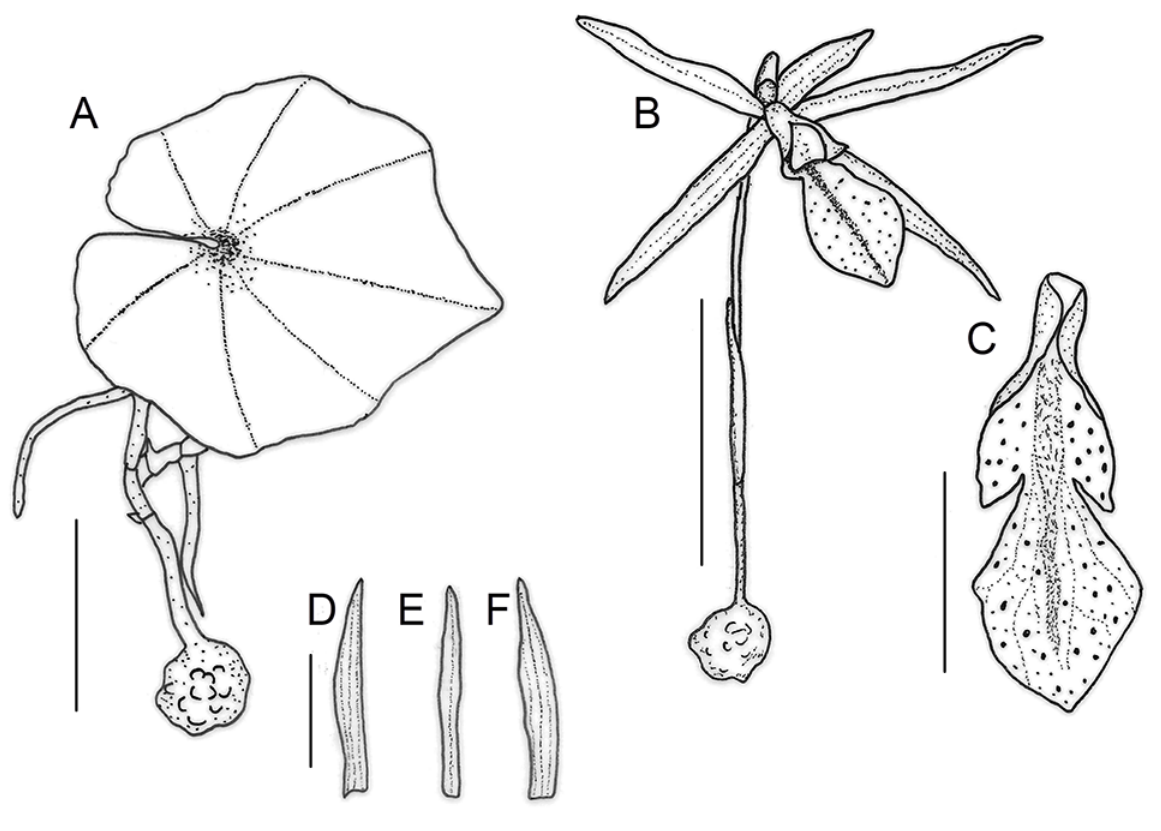
Figure 6 Nervilia punctata . ( A ) Habit in the leafy stage. ( B ) Inflorescence. ( C ) Lip. ( D ) Lateral sepal. ( E ) Petal. ( F ) Dorsal sepal. Scale bars: 2 cm ( A,B ); 5 mm ( C–F ). Drawn by M. Lipińska.